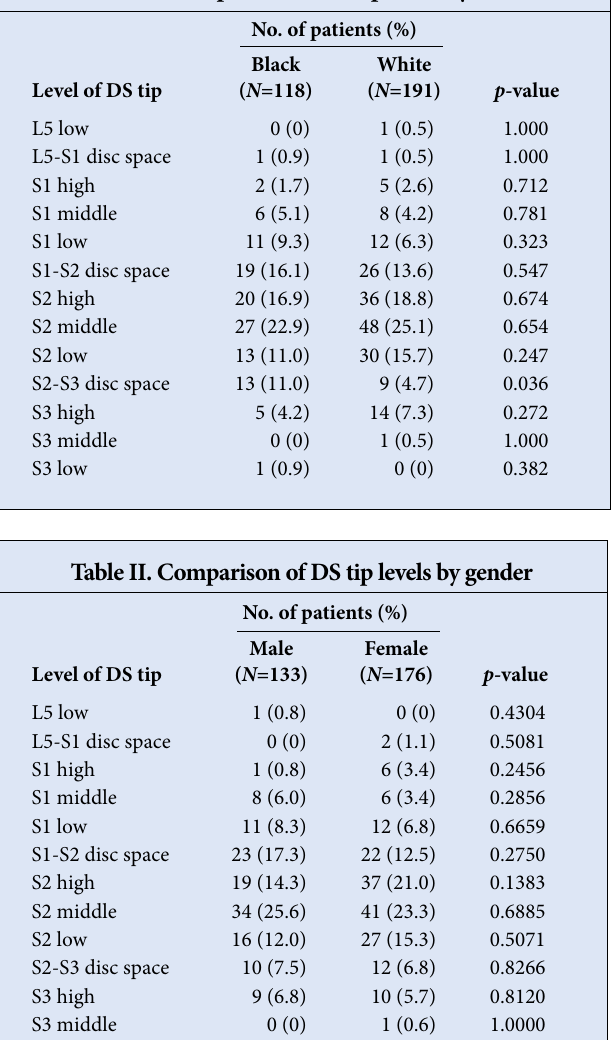
Table I. Comparison of DS tip levels by race